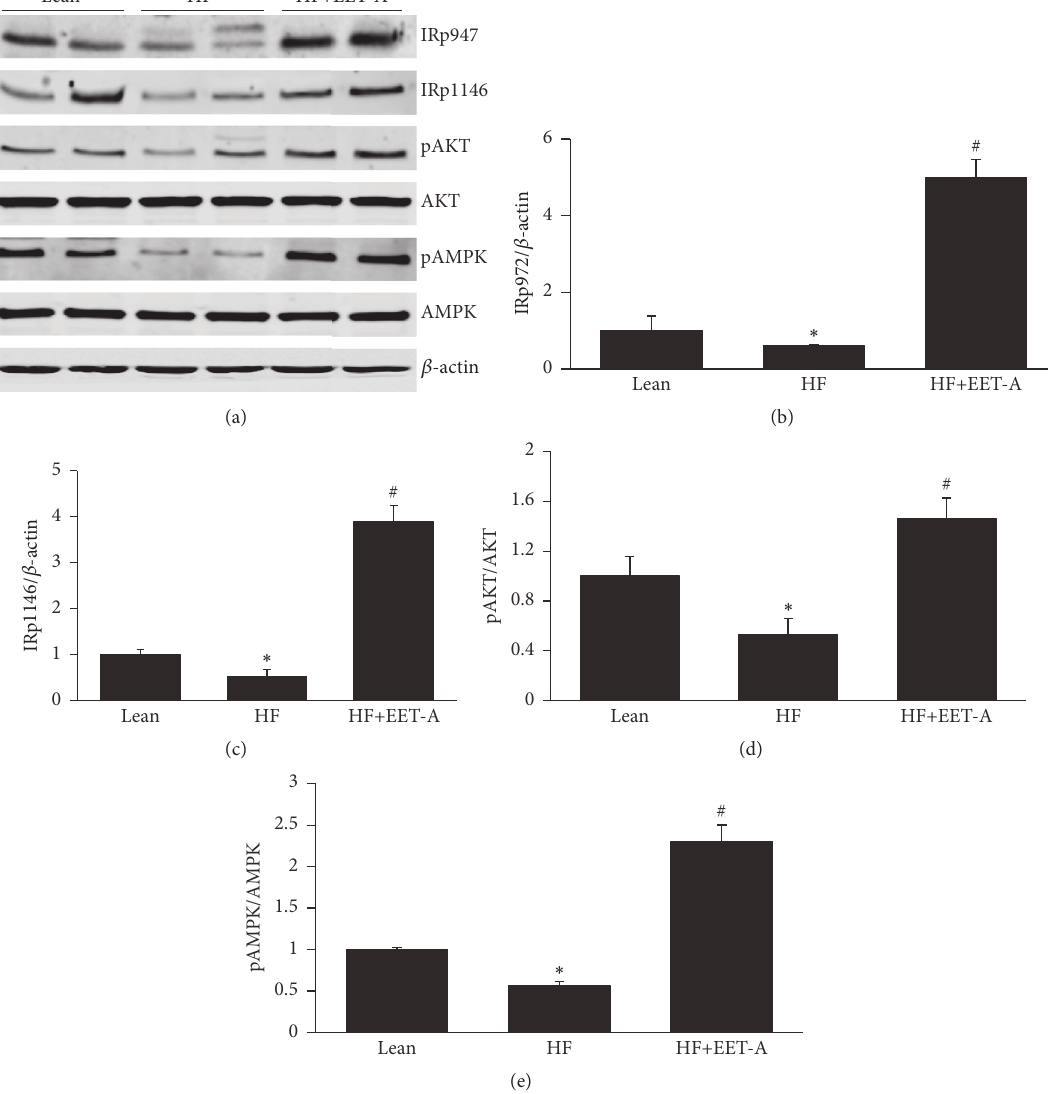
Figure 4: Effect of short-term EET-A treatment on insulin receptor phosphorylation and AKT and AMPK signaling in adipose tissue of mice fed HF diet. (a) Representative western blots and ((b) to (f)) densitometry analyses of WBs in adipose tissue of mice; (b) insulin receptor phosphorylation IRp-Tyr-972; (c) insulin receptor phosphorylation IRp-Tyr-1146; (d) phosphorylated protein kinase B (pAKT); (e) phosphorylated adenosine monophosphate protein kinase (pAMPK) proteins in mice fed a normal diet lean and mice fed a high fat (HF) diet treated with EET-A. Results are mean ± SE, 𝑛 = 4 , ∗ 𝑝 < 0.05 versus lean, and # 𝑝 < 0.05 versus